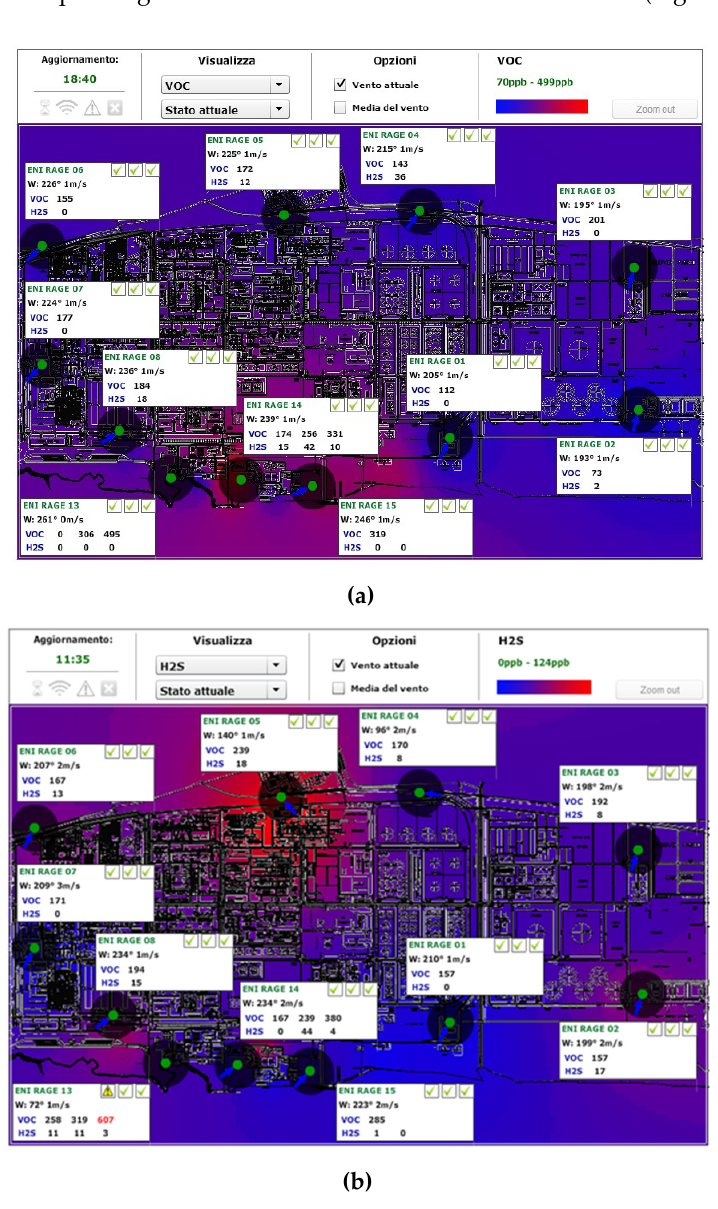
Figure 13. Pseudo-colour map of ( a ) VOC and ( b ) H 2 S concentrations over the RAGE refinery area.